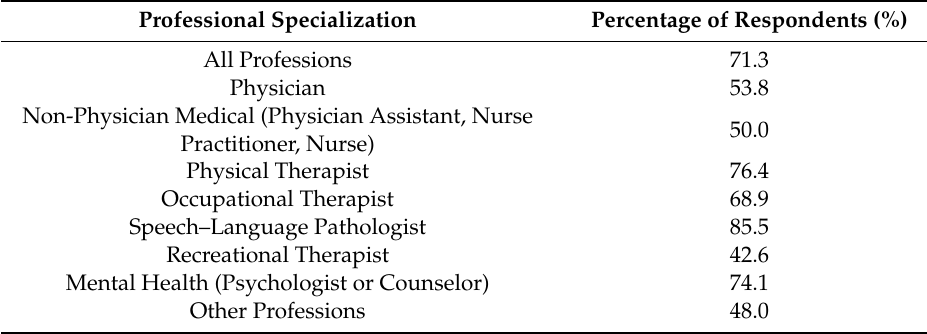
Table 5. Percentage of respondents who prescribe specific exercises and interventions for patients to work on outside of the clinic or at home, by